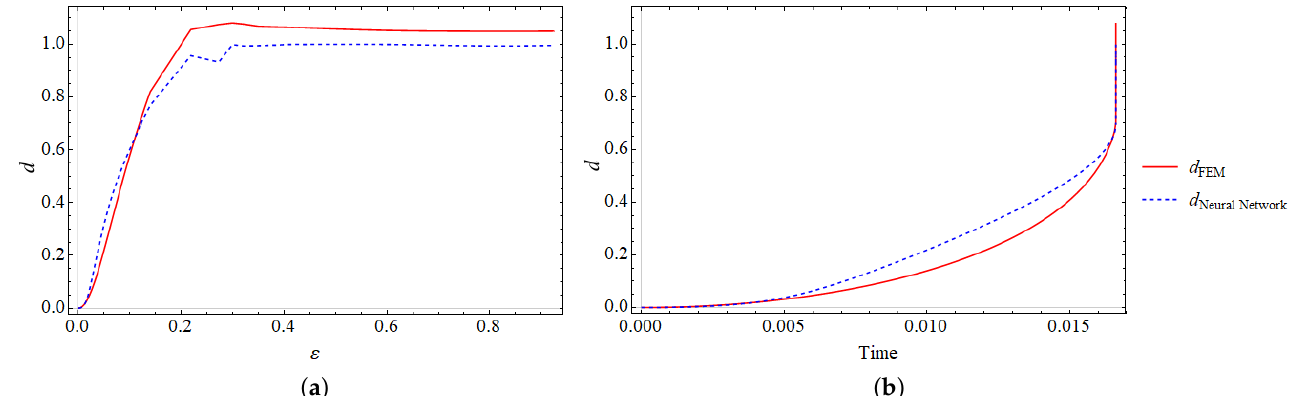
Figure 16. Case 2: Single-edge notched tension test. Fracture phase-field d curves versus strain ε in ( a ) and vs. time t in ( b ).